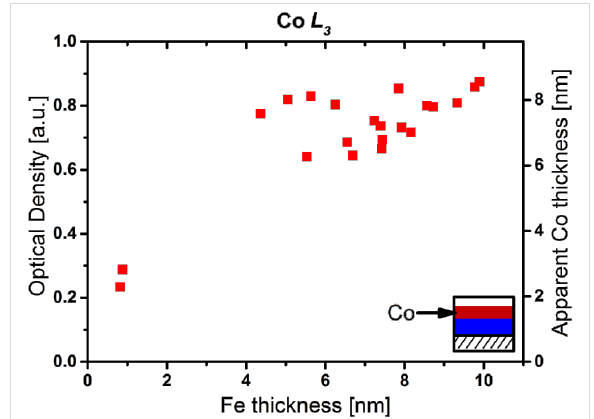
Figure 7: Optical density at the Co L 3 edge and apparent cobalt thick- ness of CoO x N y C z layers grown autocatalytically from Co(CO) 3 NO on Fe layers plotted against the Fe layer thickness. The Fe layers were prepared by EBID and autocatalytic growth by using Fe(CO) 5 . In a second step, Co(CO) 3 NO was dosed for 210 min to produce the CoO x N y C z layers via (auto-)catalytic decomposition. The optical density and thickness are corrected to account for the absorption of the Fe deposit underneath (see text). The OD of the CoO x N y C z layer is almost independent of the Fe layer thickness for Fe layers thicker than 4